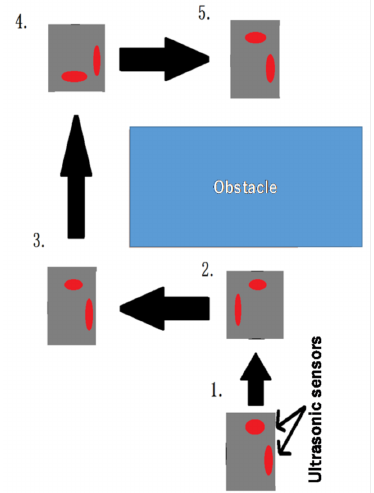
Figure 7. Returning to regular travel after avoiding obstacle.